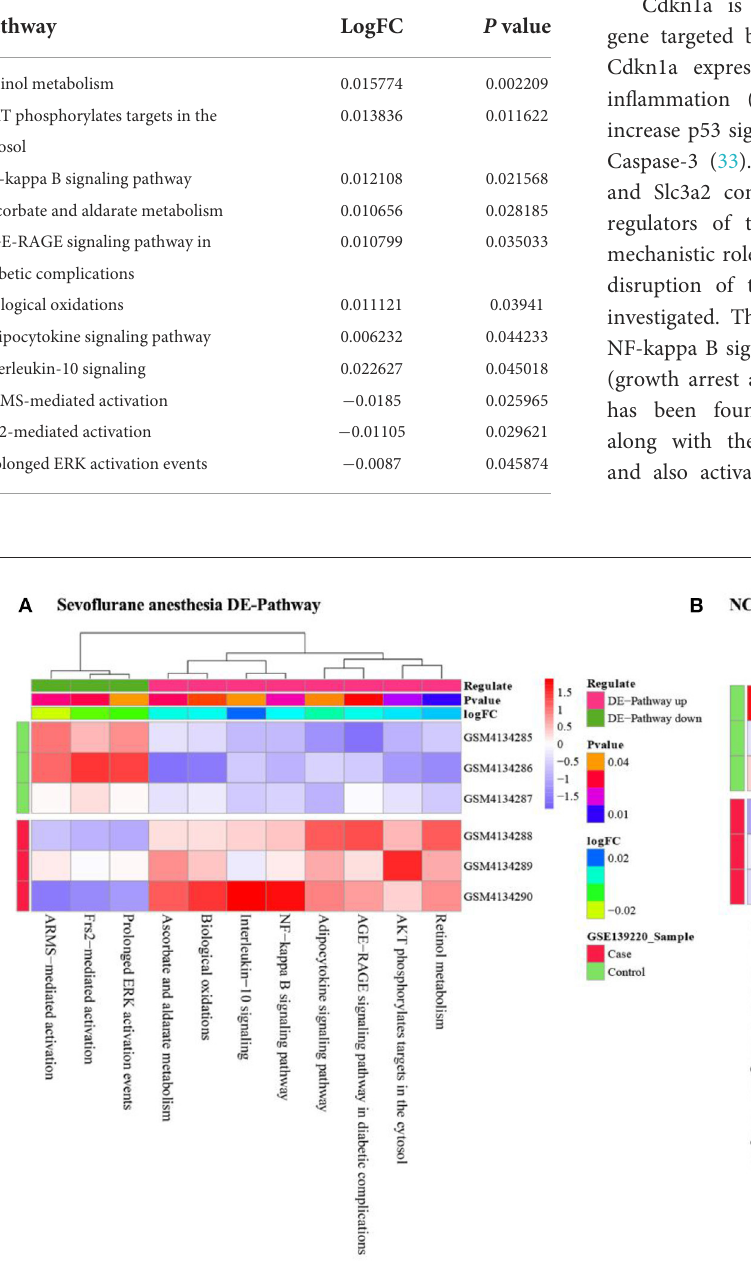
FIGURE6 Enrichment abundance of (A) Sevoflurane anesthesia DE-pathway and (B) NCD hub